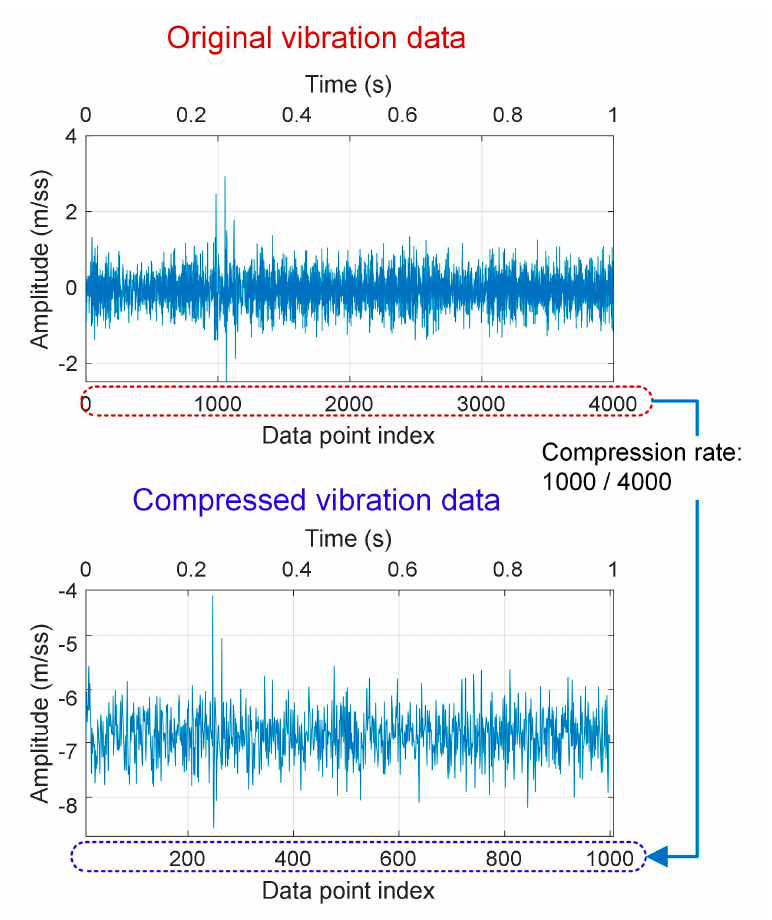
Figure 22. RPD: vibration data compression. Next, the frequency spectrum of the compressed vibration data was calculated using discrete Fourier transform: the spectrum is shown in Figure 23.